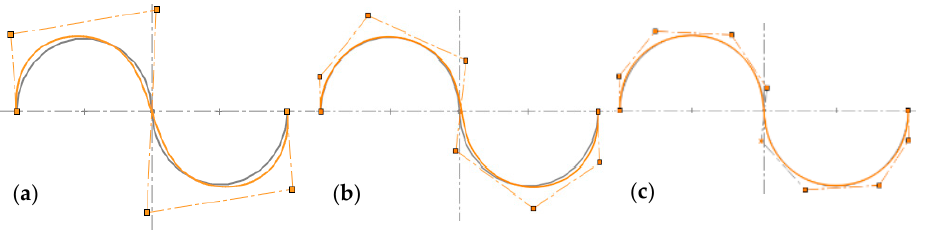
( b ) Figure 8. Fluctuation of curve fitting accuracy when ( a ) Max_iter is 20 and W varies from 10 to 100, and when ( b ) W is 20 and Max_iter varies from 10 to 50 . As shown in Figure 8a, Max_iter is 20. When W is 10 and 20, the result fluctuates greatly, and the fluctuation is relatively small when W is 30. In Figure 8b, W is 20, and the